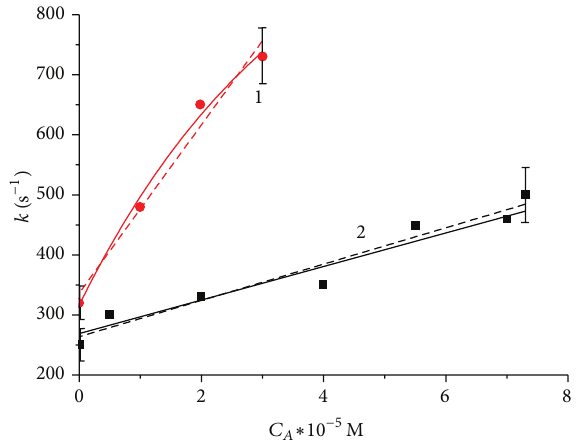
= 10 mg/mL; curve 2: 𝐶 HSA